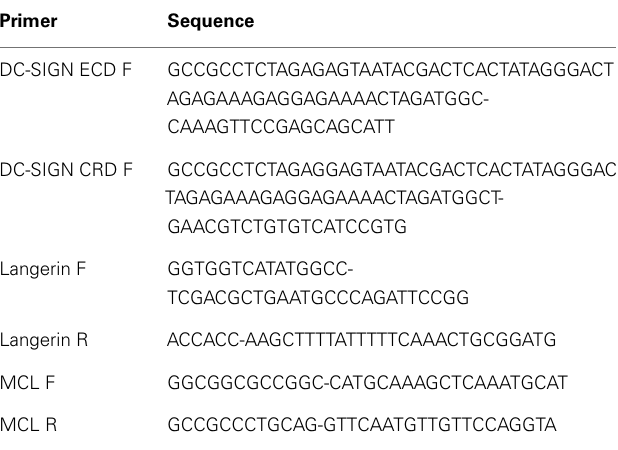
Table 2 | Primer sequences used for cloning